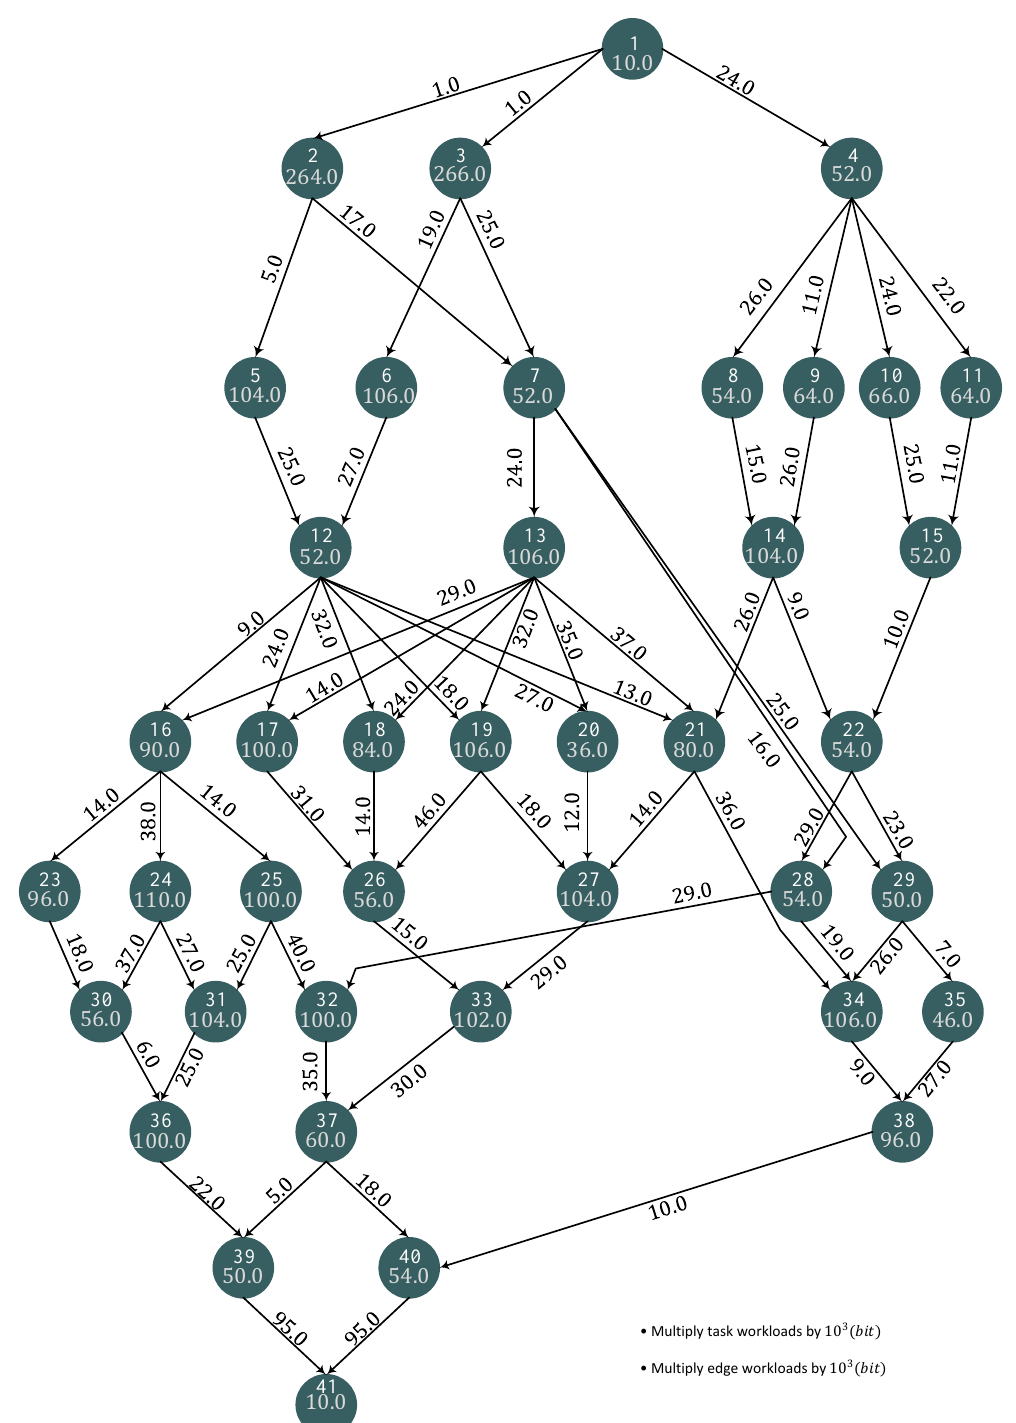
Figure 6. Graphs of the tested DAG3. All the numeric labels are in Kbit. The total workload (e.g., summation of the node labels) and inter-node traffic (e.g., summation of the edge weights) of the test DAGs are the same. They equate to 3.32 (Mbit) and 1.66 (Mbit),